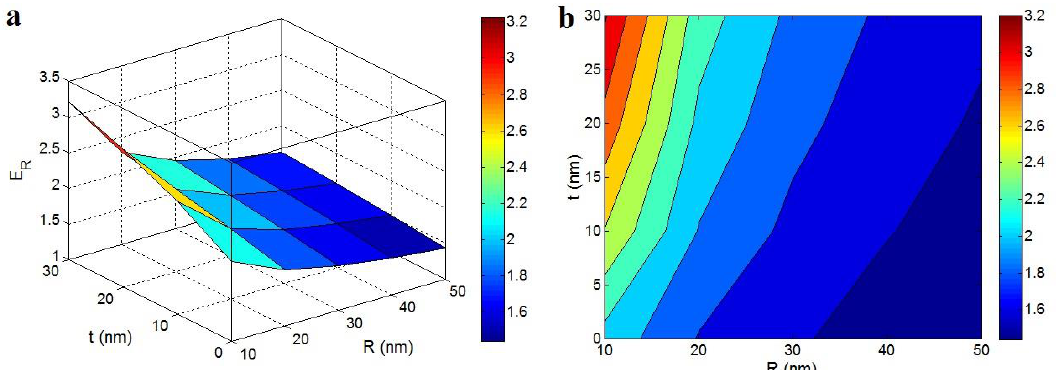
Figure 1. ( a ) 3D and ( b ) contour designs to show the relative modulus at dissimilar “ R ” and “ t ” ranges according to advanced Takayanagi model ( E m = 2 GPa, φ f = 0.02, E f = 1000 GPa, l = 5 µ m, A = 0.02 and E N = 2000 GPa).